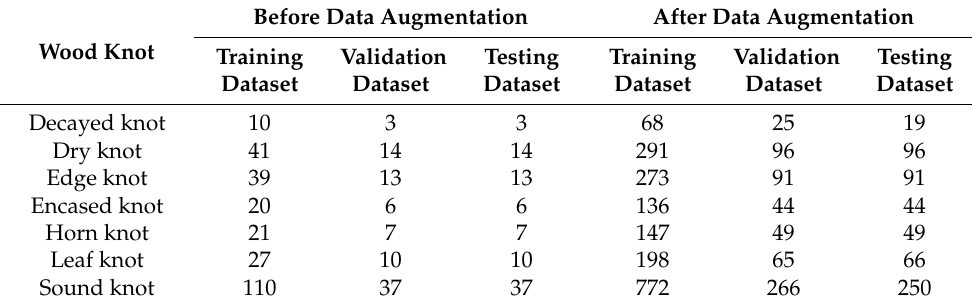
Table 1. Number of